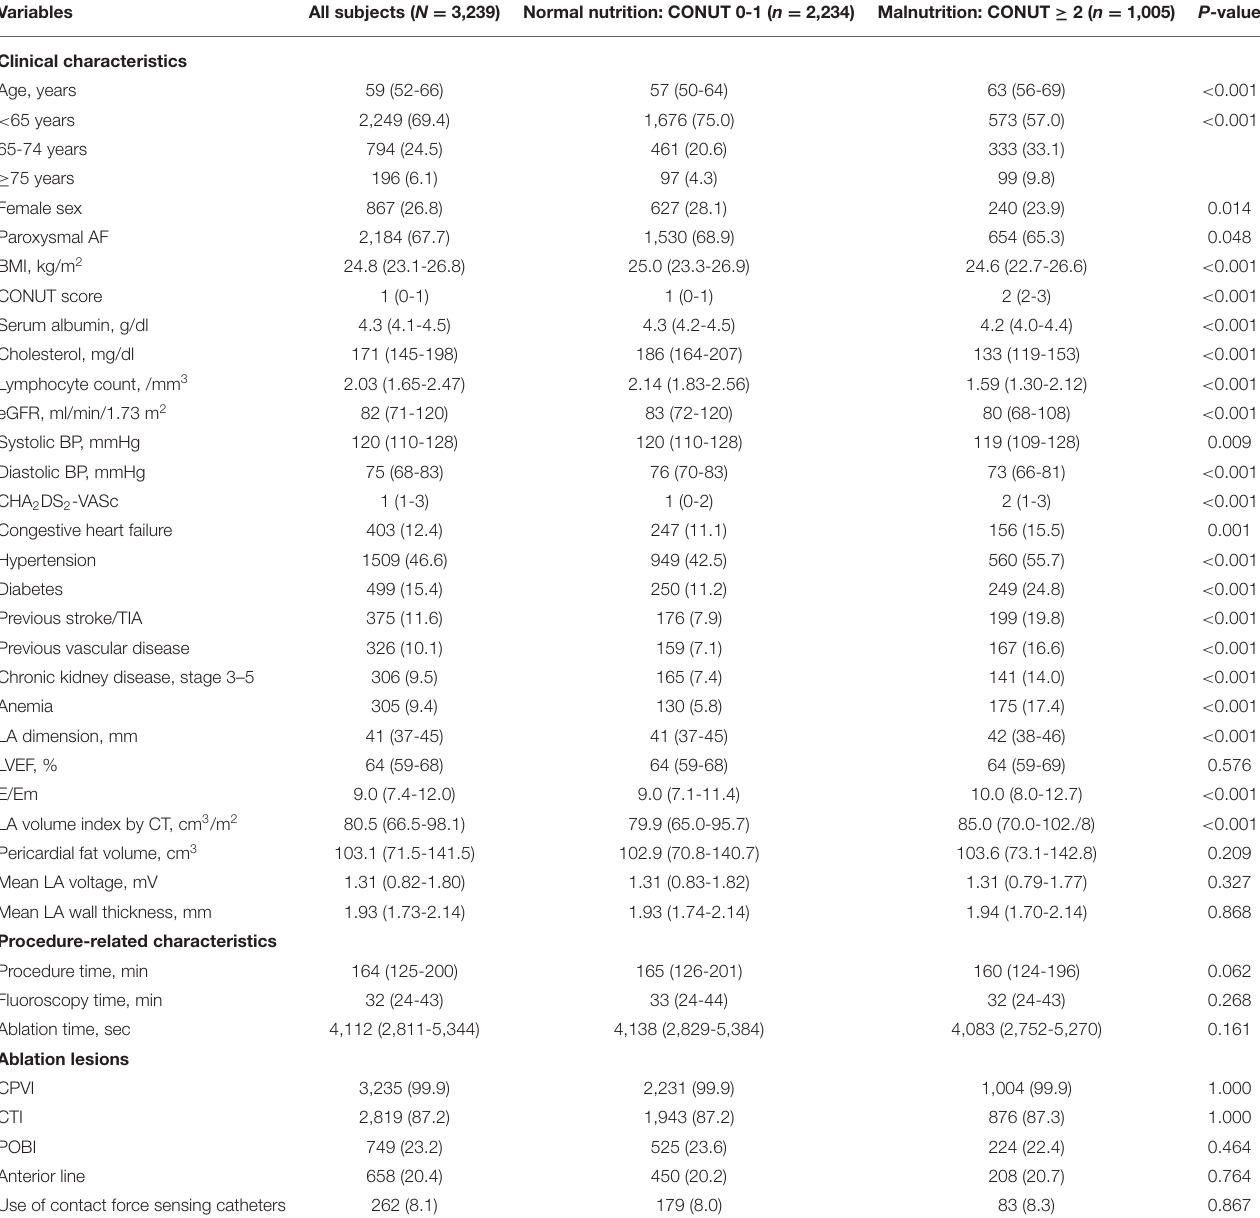
TABLE 2 | Baseline clinical and procedure-related characteristics of the patients undergoing a de novo catheter ablation of atrial fibrillation according to the nutritional status.